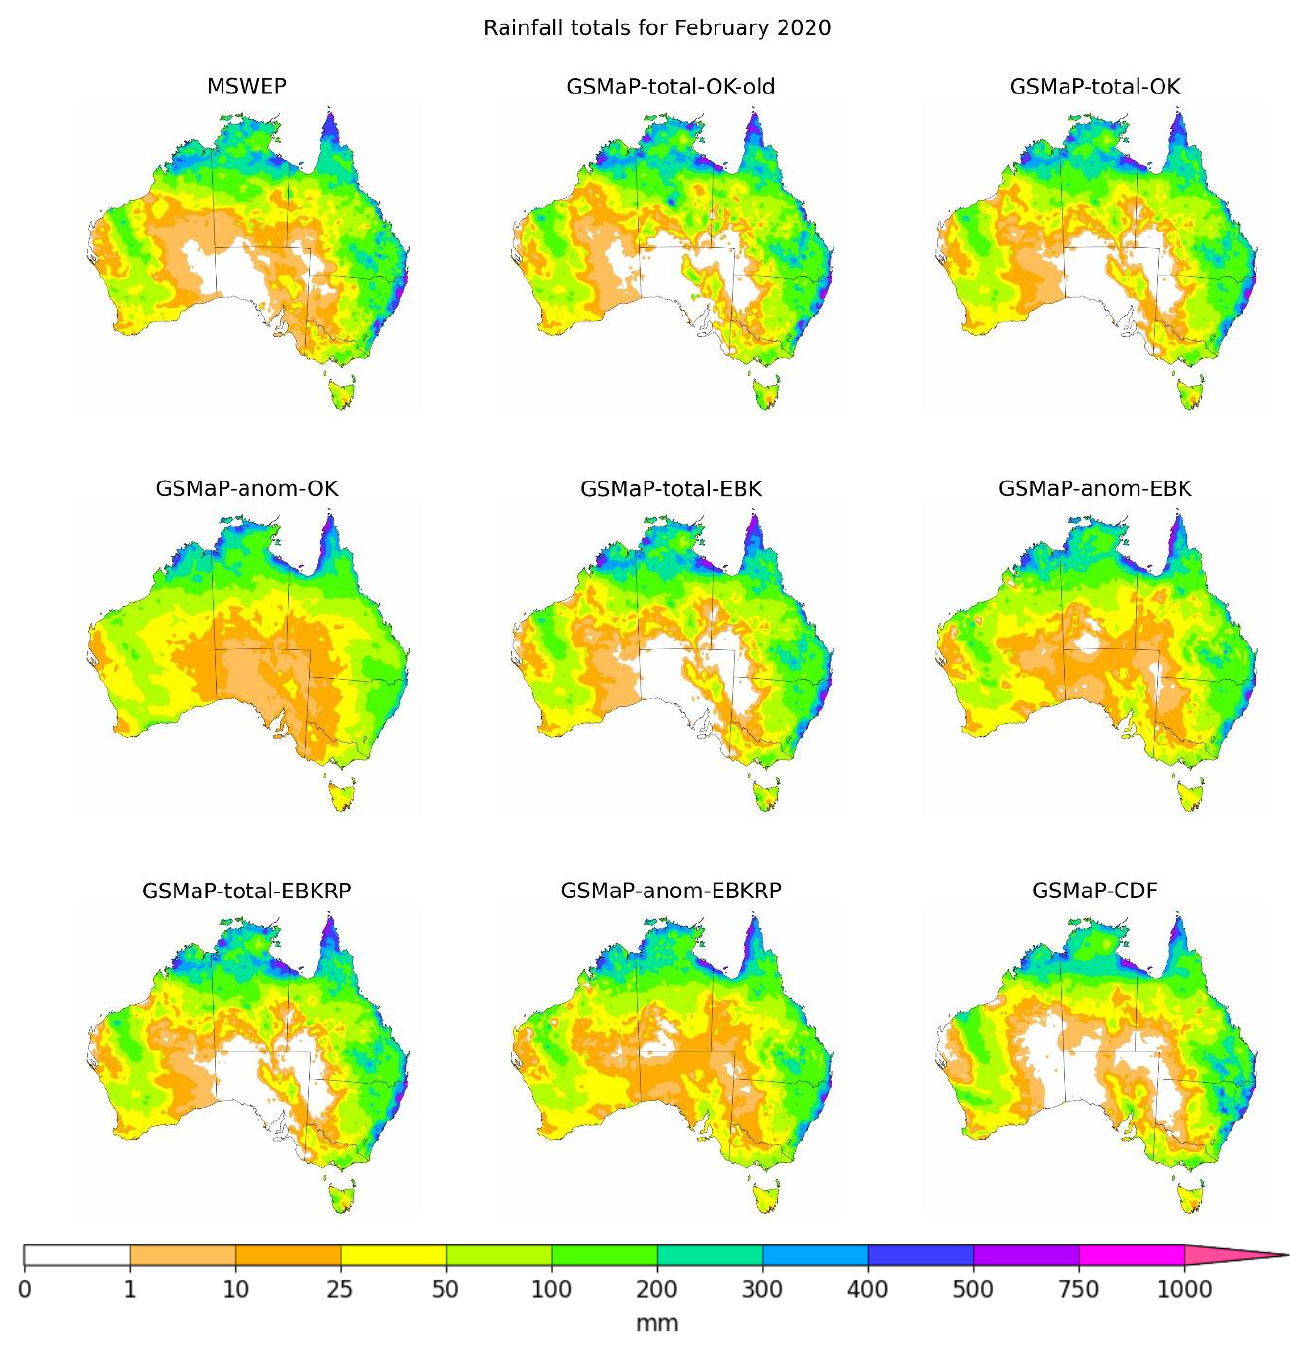
Figure 3. Corrected rainfall analyses for February 2020. CDF correction appeared to have the most spatially consistent rainfall patterns, in- cluding having the least artifacts, but it had problems depicting the correct magnitudes. Table 3. Verification statistics for blended datasets with AGCD included as a reference. Underestimation over western Tasmania was again an issue. The EBK and EBKRP methods had slightly fewer artifacts than the OK